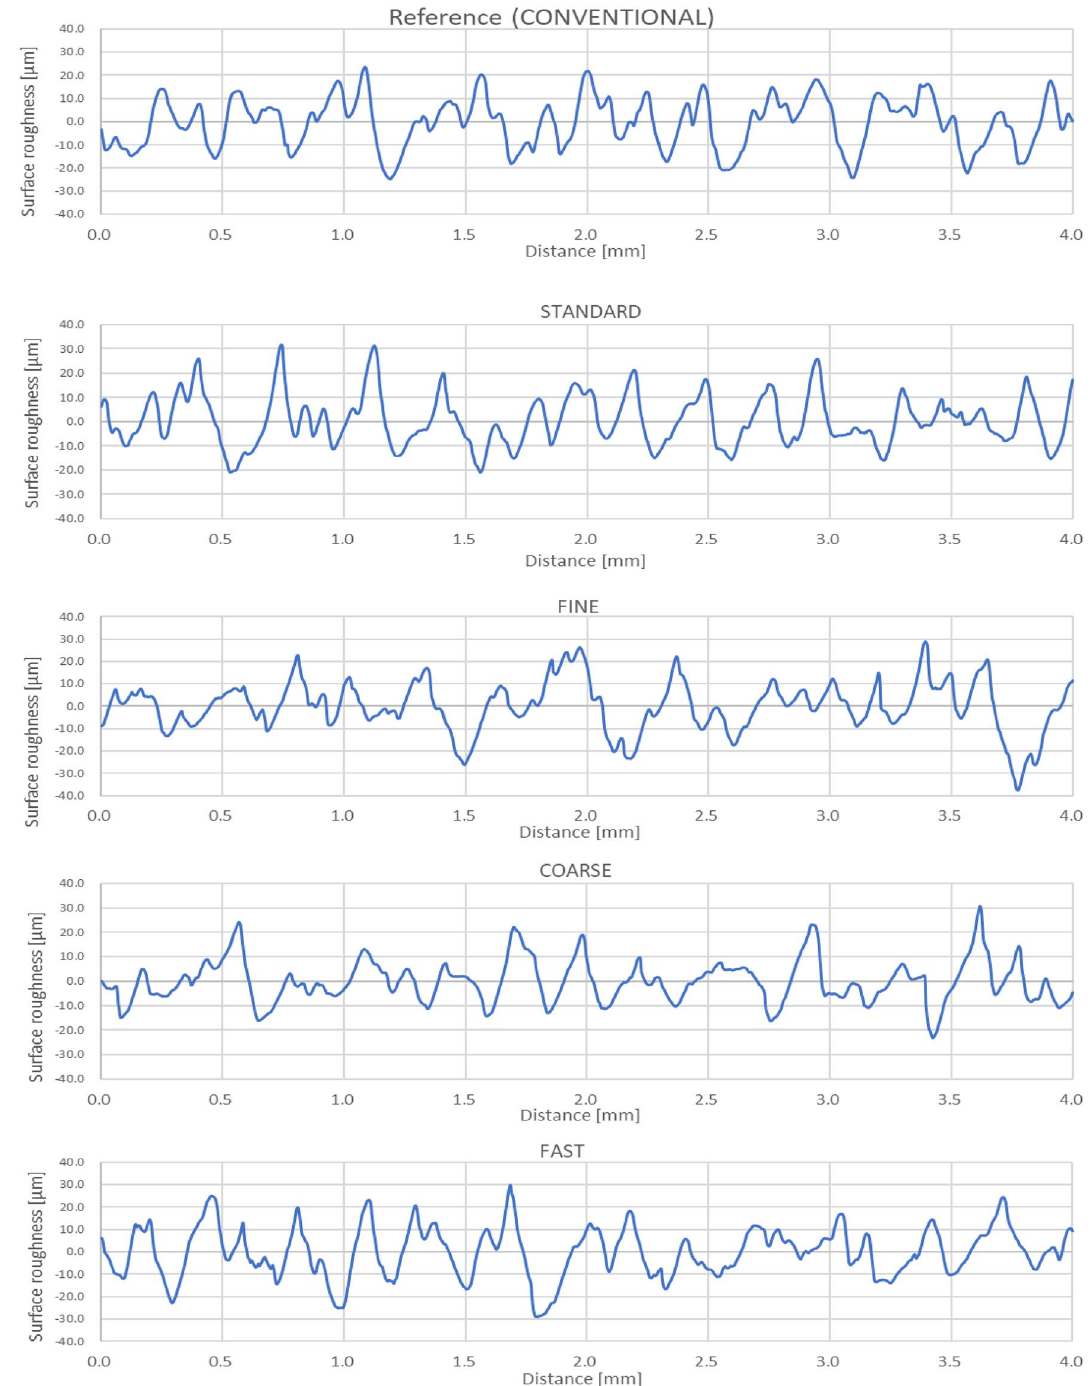
Figure 2. Cross-sectional profiles of the conventional Pe-Lite together with four of surfaces machined by Biomill CNC milling